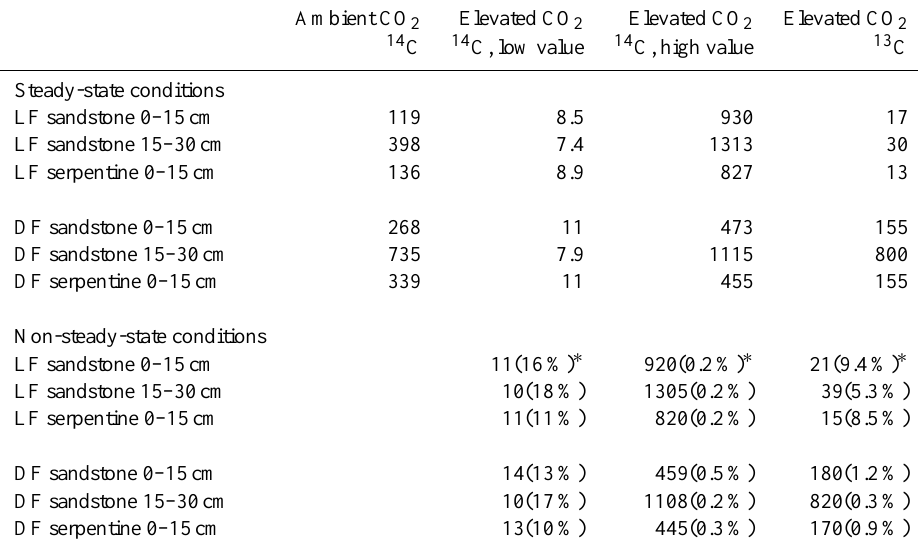
∗ Numbers in bracket are percent increase in soil carbon pool from pre-experiment years (before 1992) to 1997 as a result of increased plant inputs in the elevated CO 2 treatment.